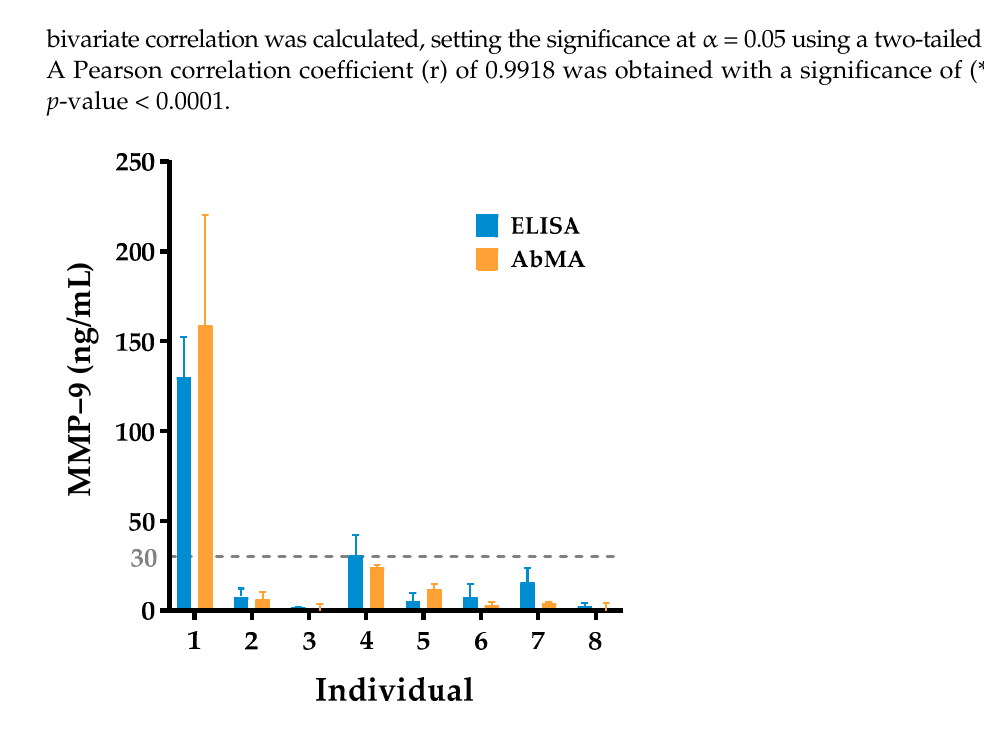
Figure 2. Concentration of MMP-9 in the collection of tear samples from healthy controls, without any ocular disorder diagnosed, using ELISA (blue) as the gold standard technique and AbMAs (orange). MMP-9 concentration is represented as ng/mL for each individual. A gray line is plotted at 30 ng/mL of MMP-9 enzyme in tear, the threshold value at which higher concentrations are considered a sign of ocular inflammation.